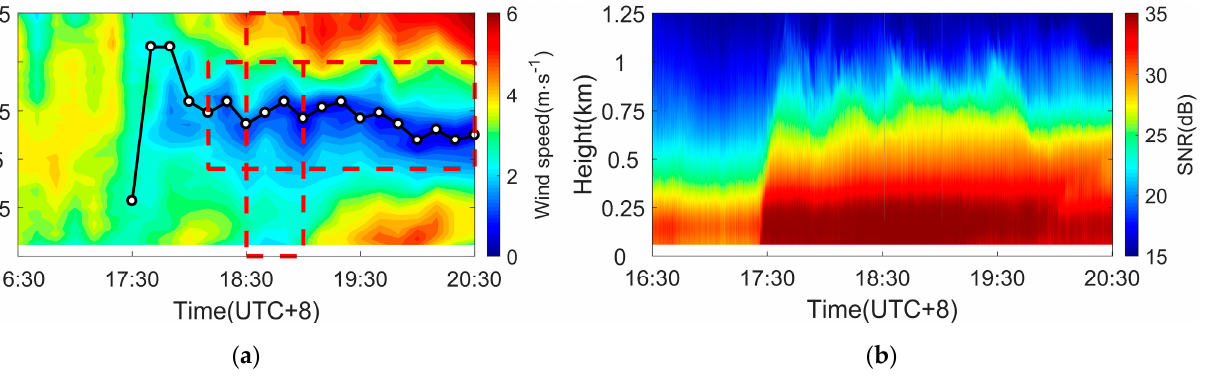
Figure 11. The influence of Kelvin–Helmholtz instability during the sea breeze penetration on 25 September 2019. ( a ) The oscillation of horizontal wind speed. The black line with circles represents the boundary between the sea breeze and the high-altitude return flow, the same later; ( b ) The SNR of lidar.